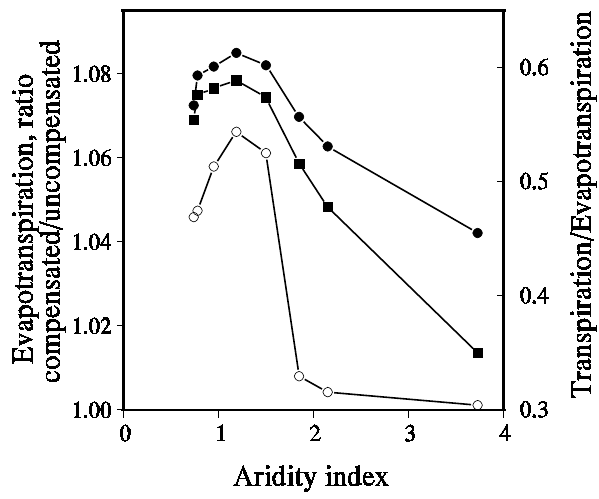
Fig. 10. Transpiration and evapotranspiration simulated by com- pensated and uncompensated models as a function of the aridity in- dex (defined here as 1.3 x equilibrium evaporation divided by pre- cipitation). Open symbols are the evapotranspiration ratio (com- pensated/uncompensated; plotted against the left axis); closed sym- bols (right-hand axis) show the ratio of transpiration to evapotran- spiration (circles=compensated model, squares=uncompensated